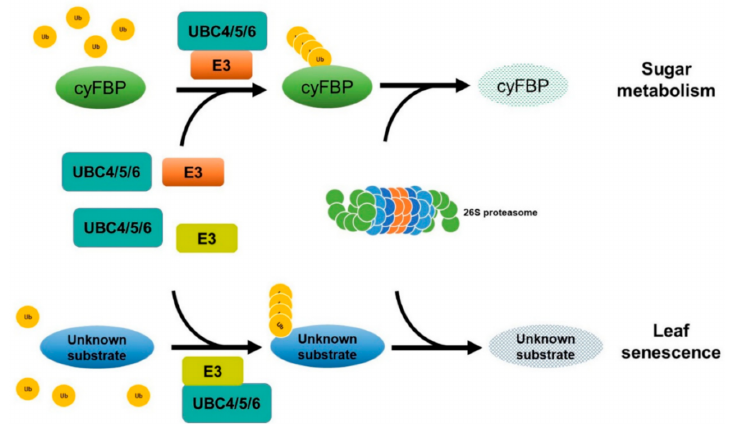
Figure 9. A model to show the functions of UBC4, UBC5, and UBC6 in sugar metabolism and leaf senescence. UBC4, UBC5, and UBC6, the three members of the E2 subfamily IV, together with an E3 yet to be identified, target and most likely ubiquitinate a key gluconeogenic enzyme, the cytosolic fructose-1, 6-bisphastase (cyFBP), which is involved in sugar metabolism in plants. When the three genes are inactivated, cyFBP accumulates, resulting in increased levels of glucose and sucrose in the leaves. Additionally, these three E2s also function to affect leaf senescence at late stages of plant development independent of cyFBP. The substrate and E3 involved remain to be